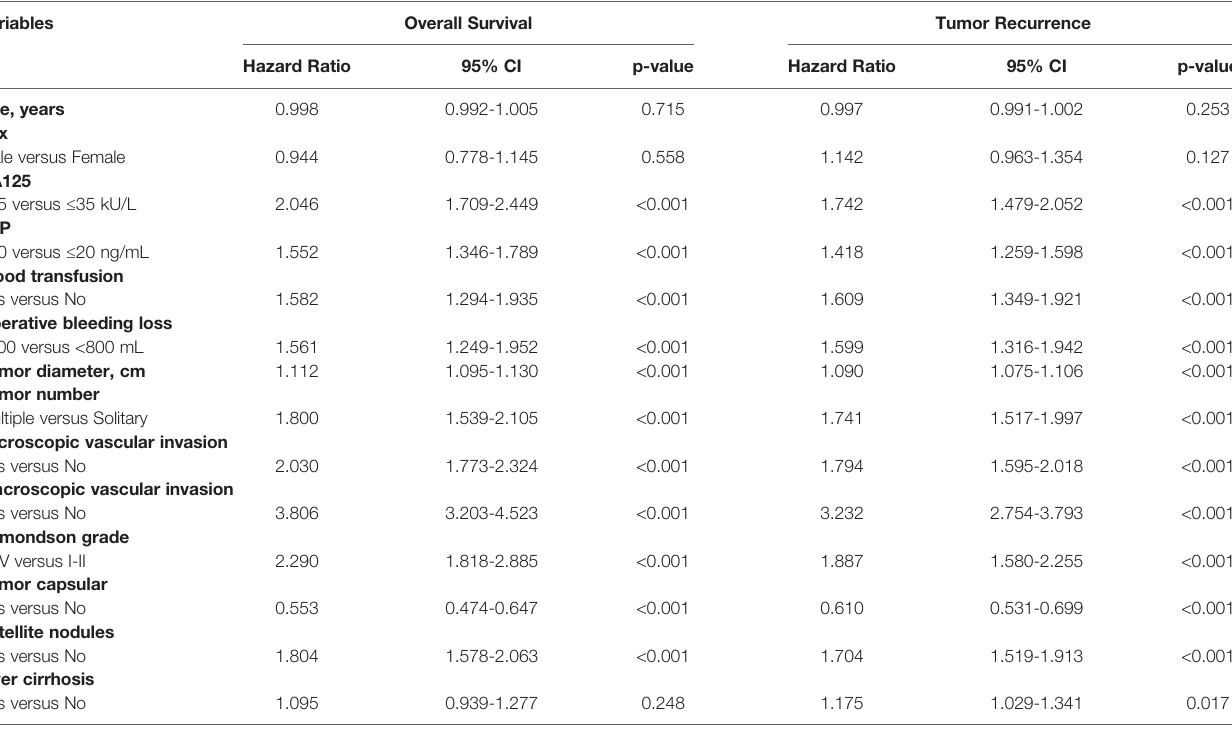
TABLE 1 | Univariate analysis of factors associated with overall survival and tumor recurrence after curative